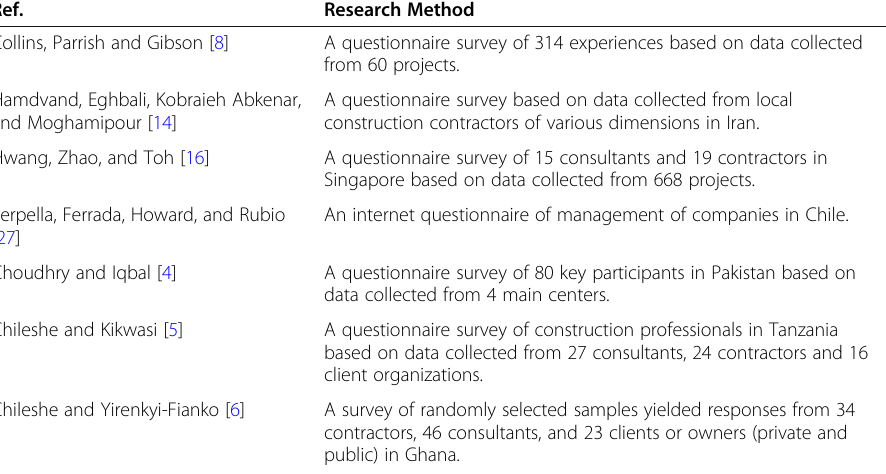
Table 1 Summary of pervious major studies (last 5 years) on RM in the construction industry, small projects, and implementation